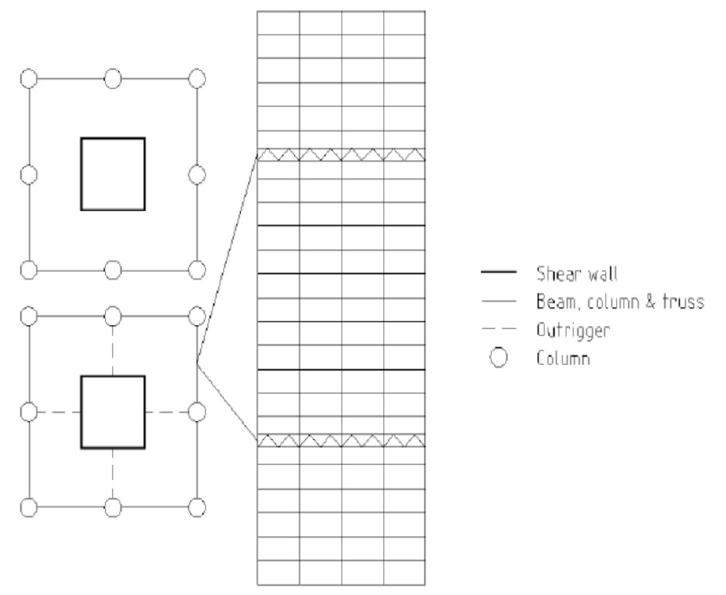
Figure 4. Plan and side view of outrigger-braced system. Source: